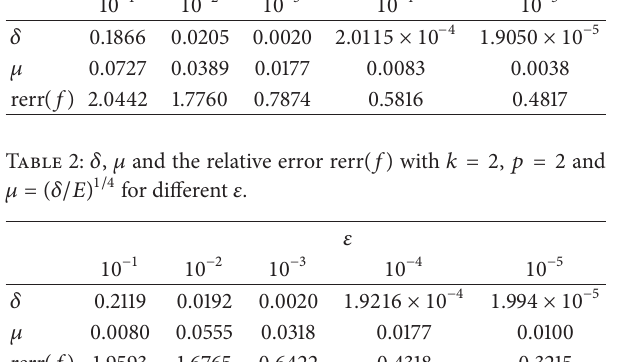
Figure 9: Comparison between the exact solution (- - -) and its computed approximations with 𝑘 = 1 and various noise levels of 𝜀 = 0.01 (−∗−) , 𝜀 = 0.001 (− ⊳ −) , 𝜀 = 0.0001 (− o −) for Example 7.